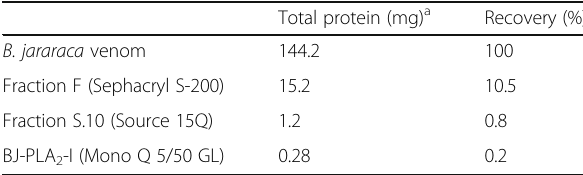
Table 1 Recovery rates of BJ-PLA 2 -I purification